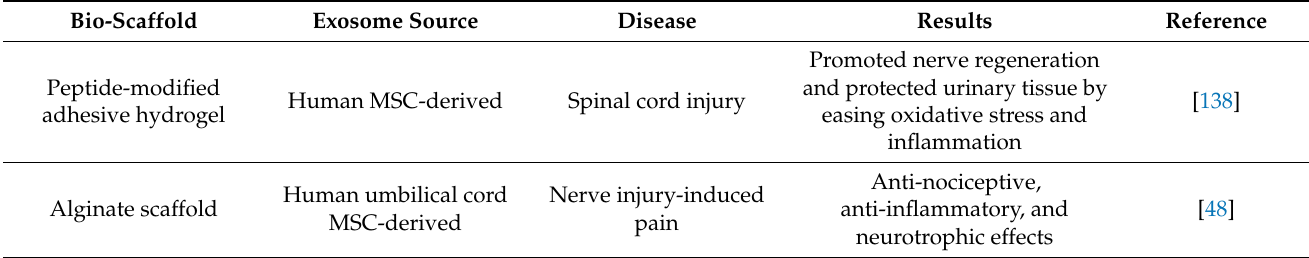
Table 3. Recent examples of exosome scaffold use in nerve injury models. Bio-Scaffold